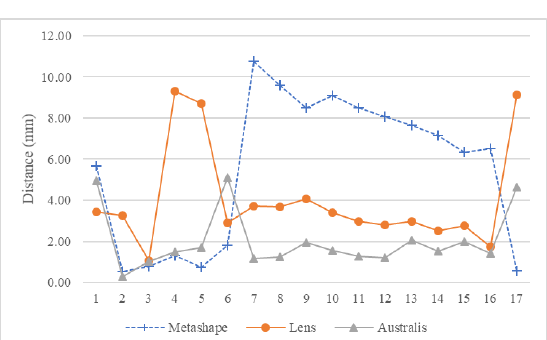
Figure 12: Check-distance error on